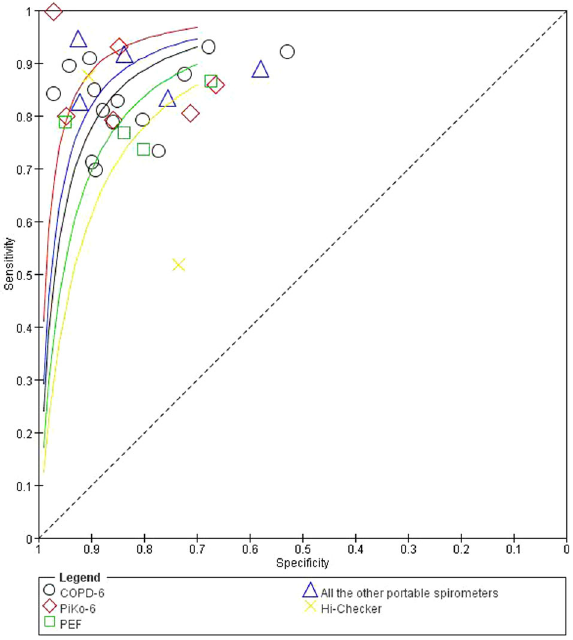
Fig. 7 The SROC of portable spirometers classi fi ed by type. All the other portable spirometers including IQ-spiro, SP10BT, Medikro SpiroStar, MS01 Micro spirometer and Spirobank